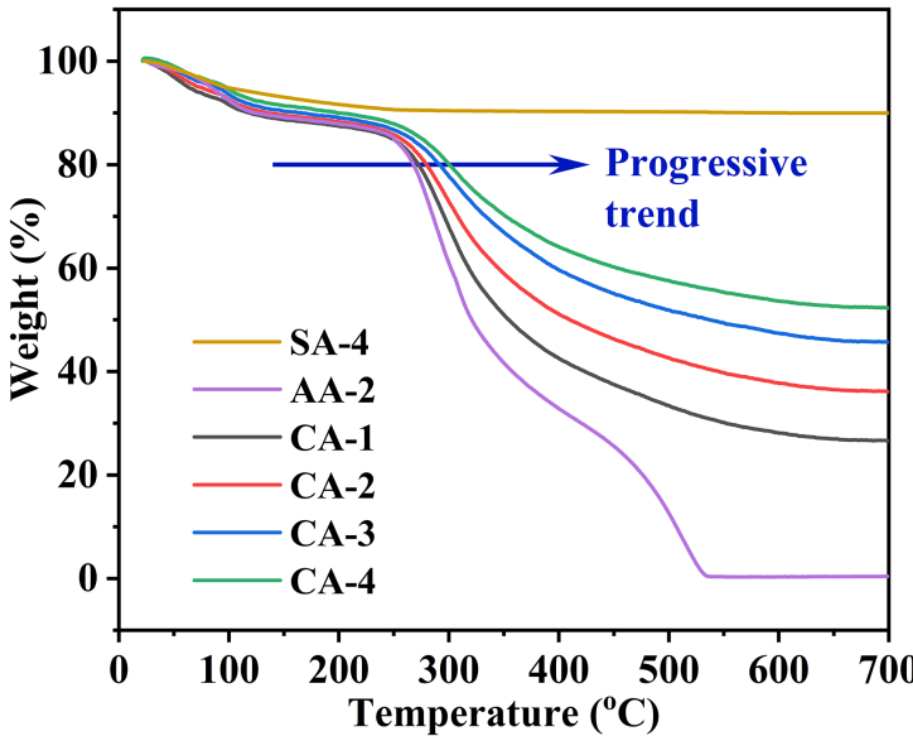
Figure 7. The TGA curve of SA-4, AA-2, and the CAs.